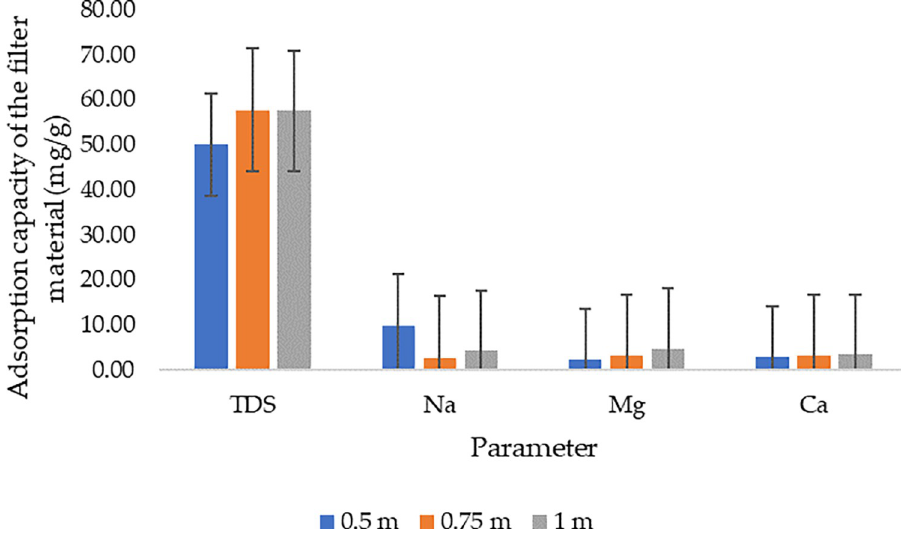
Fig 6. The adsorption capacity of the filter